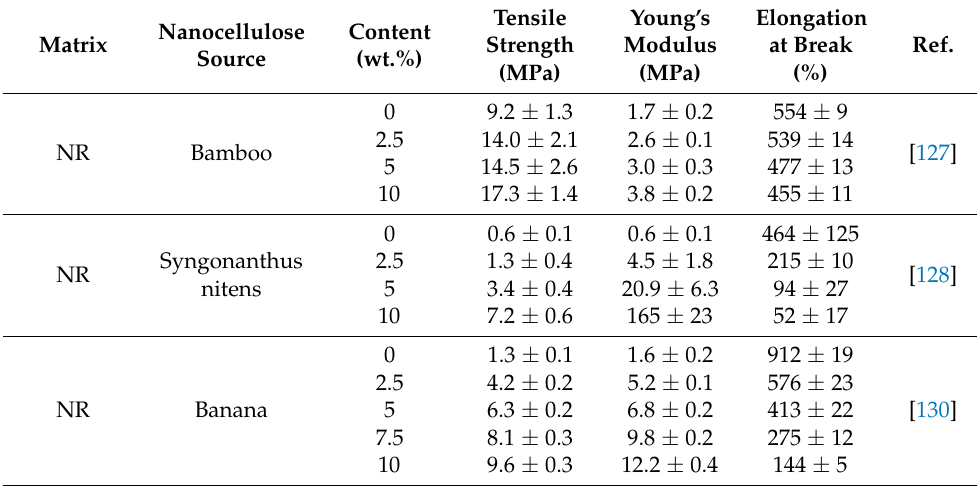
Figure 12. Typical stress–strain curves of cellulose nanowhiskers/NR nanocomposites at different filler concentrations (adapted with permission from [131]). Table 5. Mechanical properties of NR nanocomposites filled with